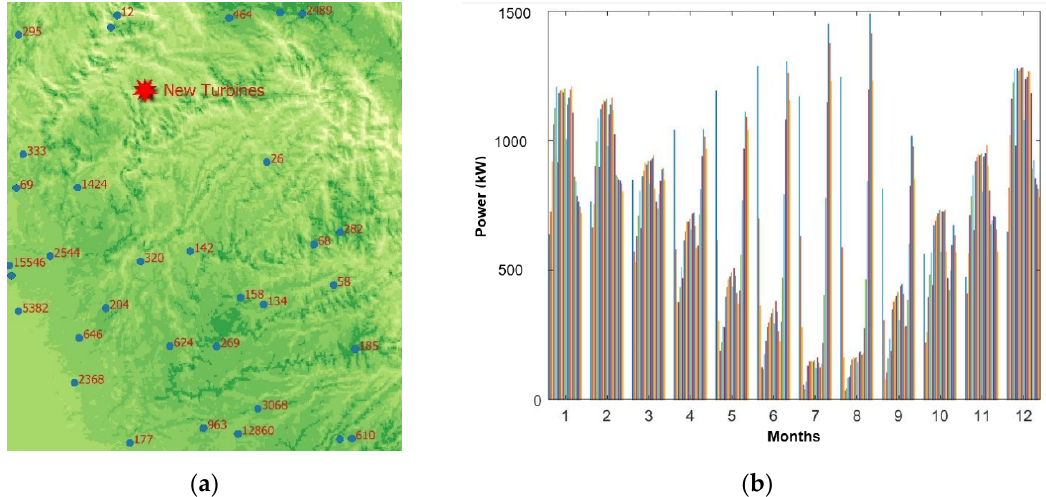
Figure 12. PSPS Cities near to the proposed new wind turbines in Northeast California. ( a ) Location map; ( b ) average hourly power output per month for one wind turbine.